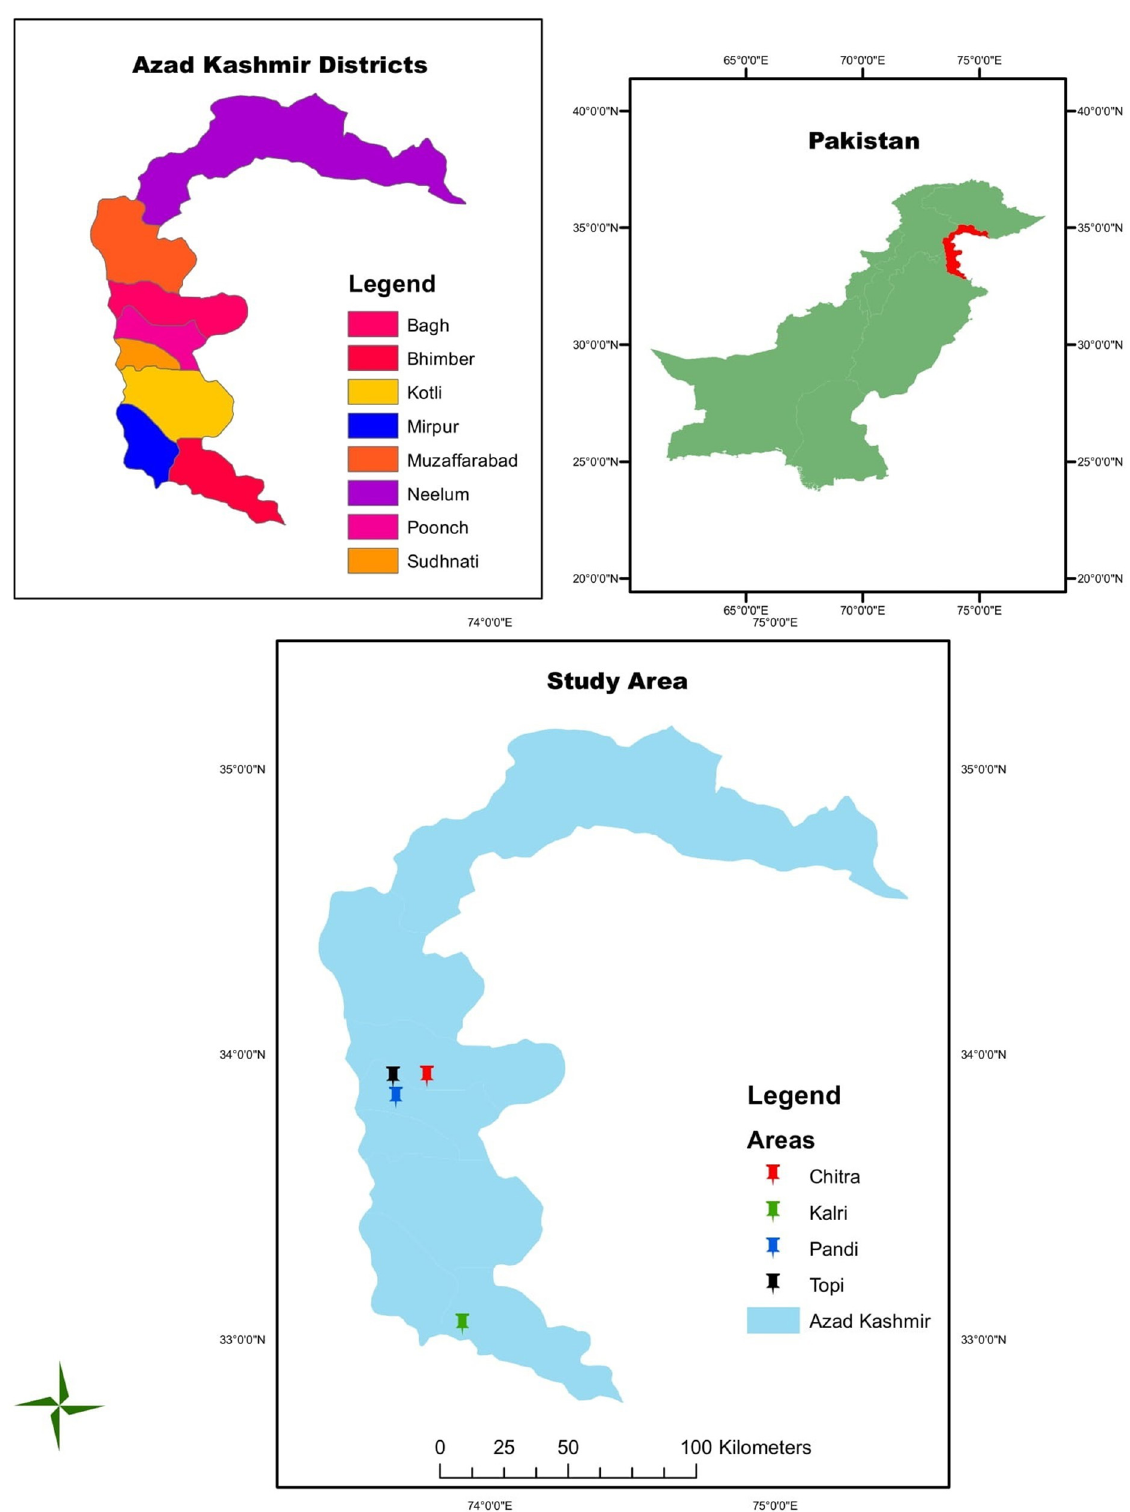
Figure 1: Map of study